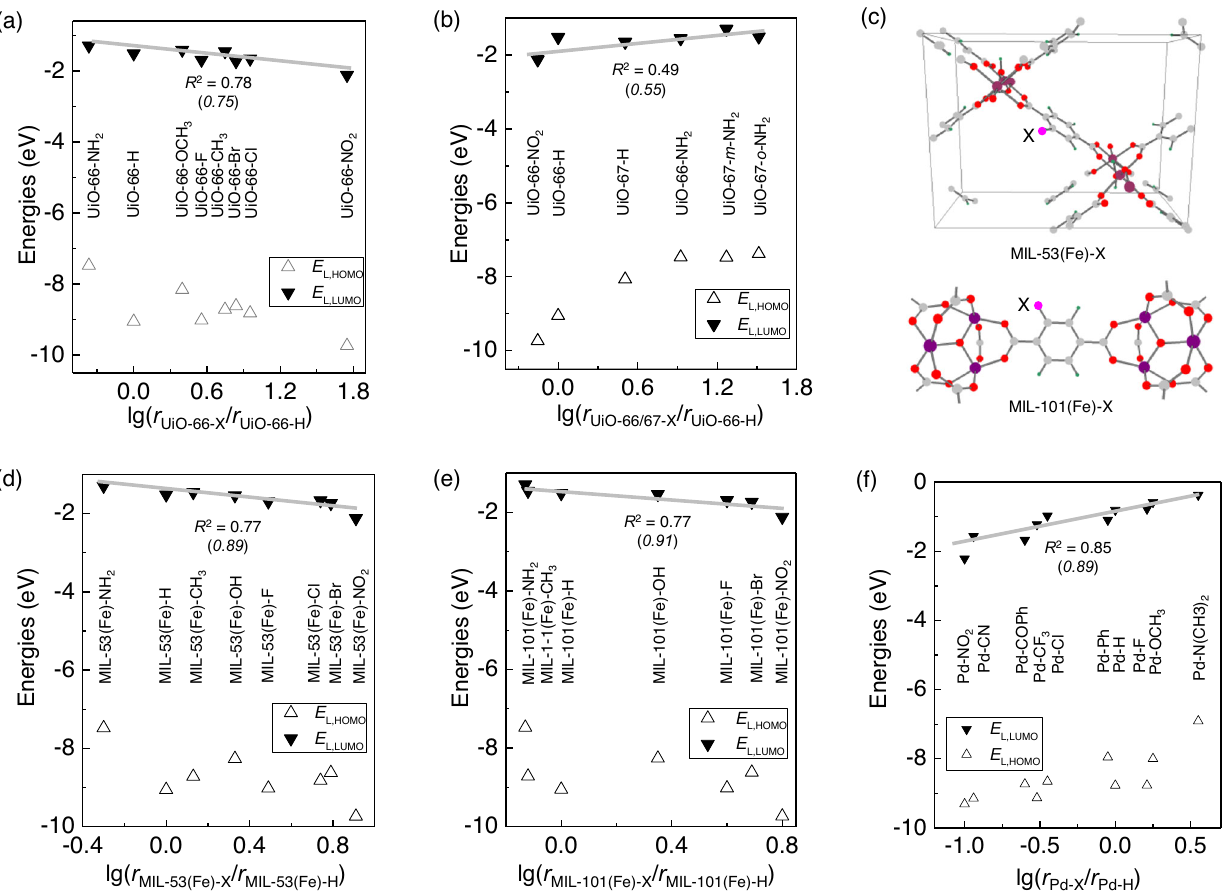
Fig. 6 Experimental veri fi cation of the prediction model. a , b Plots of E L,LUMO and E L,HOMO with the relative reaction rates of Reactions 1 and 2, respectively. c Partial structures of X-substituted MIL-53(Fe) and MIL-101(Fe) MOFs. d , e Plots of E L,LUMO and E L,HOMO with the relative reaction rates for the oxidase-like catalysis of MIL-53(Fe)-X and MIL-101(Fe)-X, respectively. f Plots of E L,LUMO and E L,HOMO with the relative reaction rates for ligand exchange of the palladium complex. In a , b , d - f , the solid lines are for eyesight